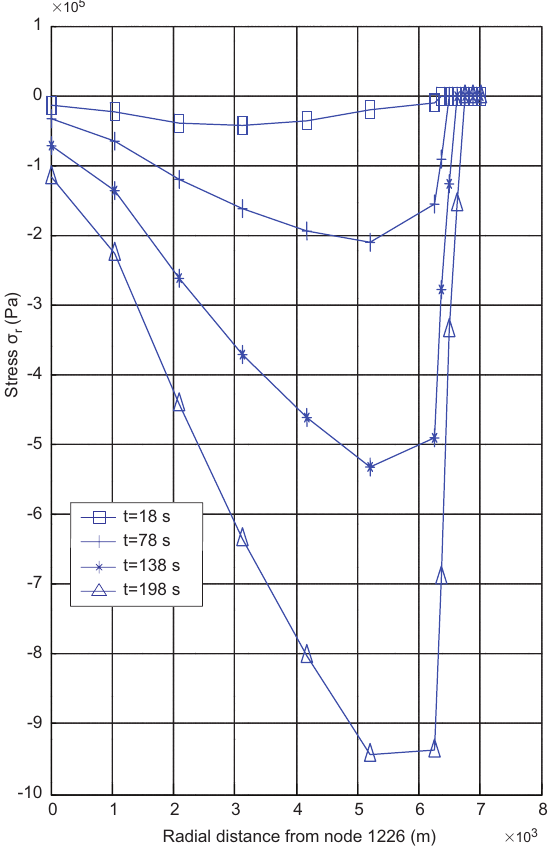
Figure 15 Radial stresses along radial direction at angle 103.5 ° from node 1226 to node 94 when moving heater is over the spot.